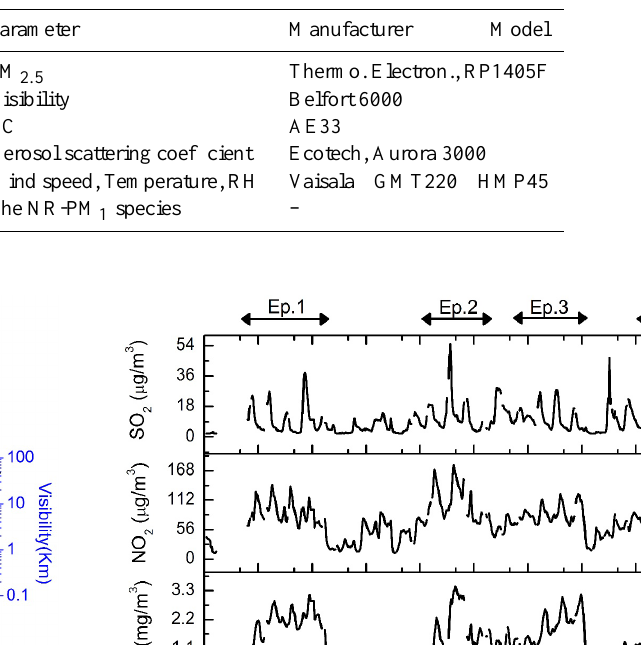
Table 1. Overview of the instruments involved in this study.